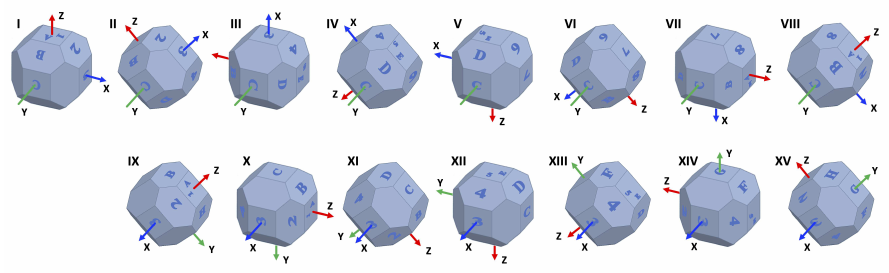
Figure 2. Polyhedron rotating sequence and its effect in the accelerometer